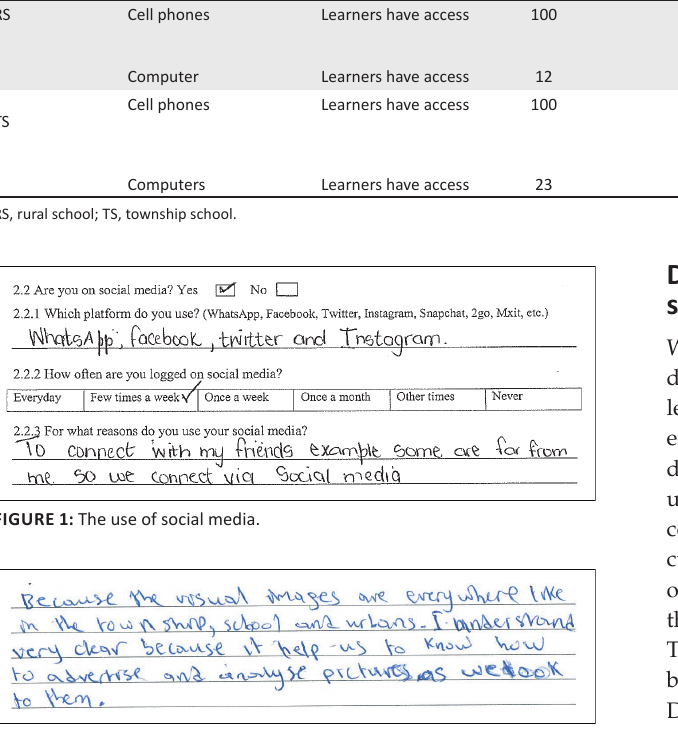
FIGURE 2: Importance of critical analysis.